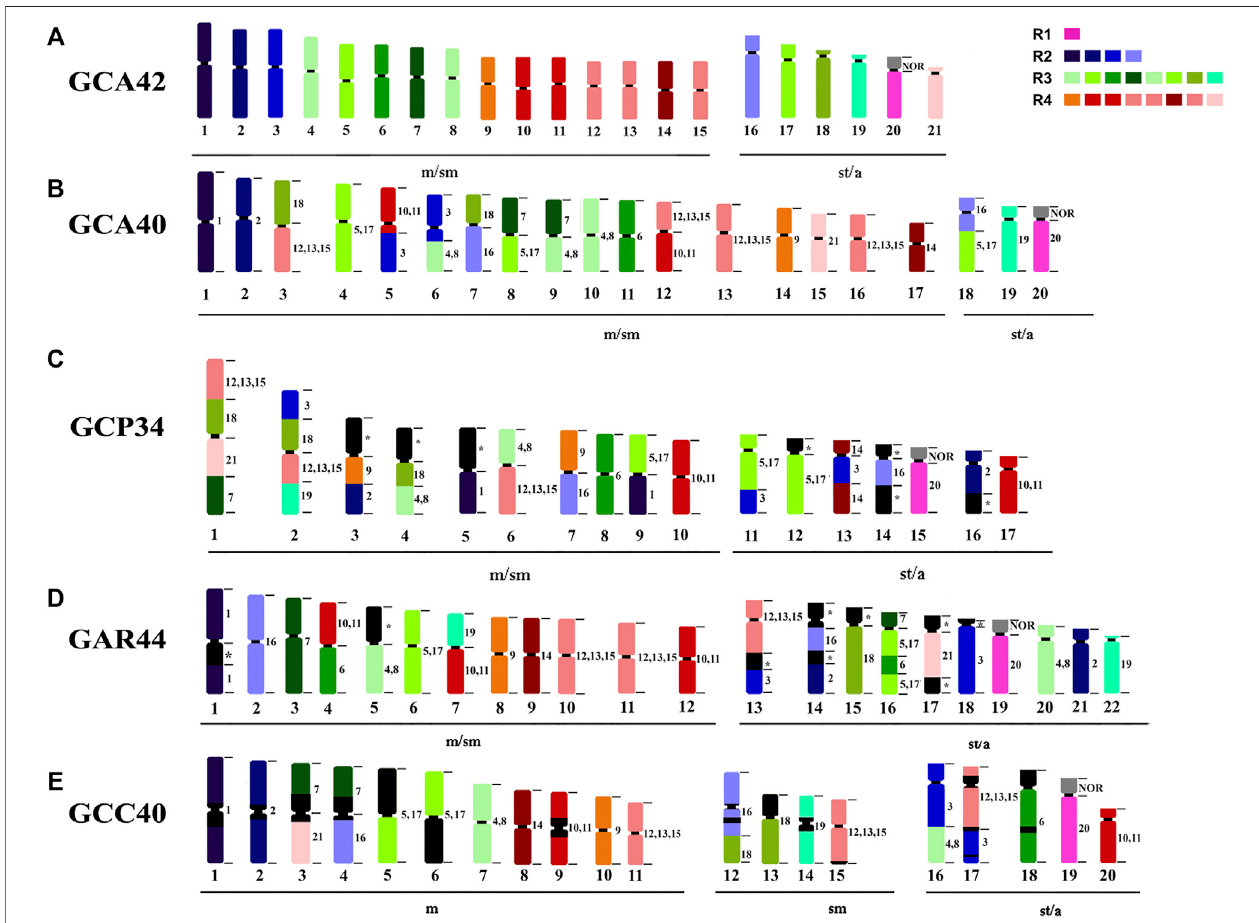
FIGURE 3 | Ideogram showing chromosome rearrangements obtained by WCP. R1, R2, R3 and R4 representing the colors of the four major regions of the G. carapo 2n=42probes. (A) G.carapo 2n=42(GCA42)utilizedintheproductionoftheprobes,eachdifferentcolorrepresentsachromosomeorchromosomegroup; (B) G. carapo 2n = 40 (GCA40) (Nagamachi et al., 2010); (C) G. capanema 2n = 34 (GCP34) (Nagamachi et al., 2013); (D) G. arapaima 2n = 44 (GAR44) (Machado et al., 2018); (E) G. carapo “ catalão ” 2n = 40 (GCC40) (present